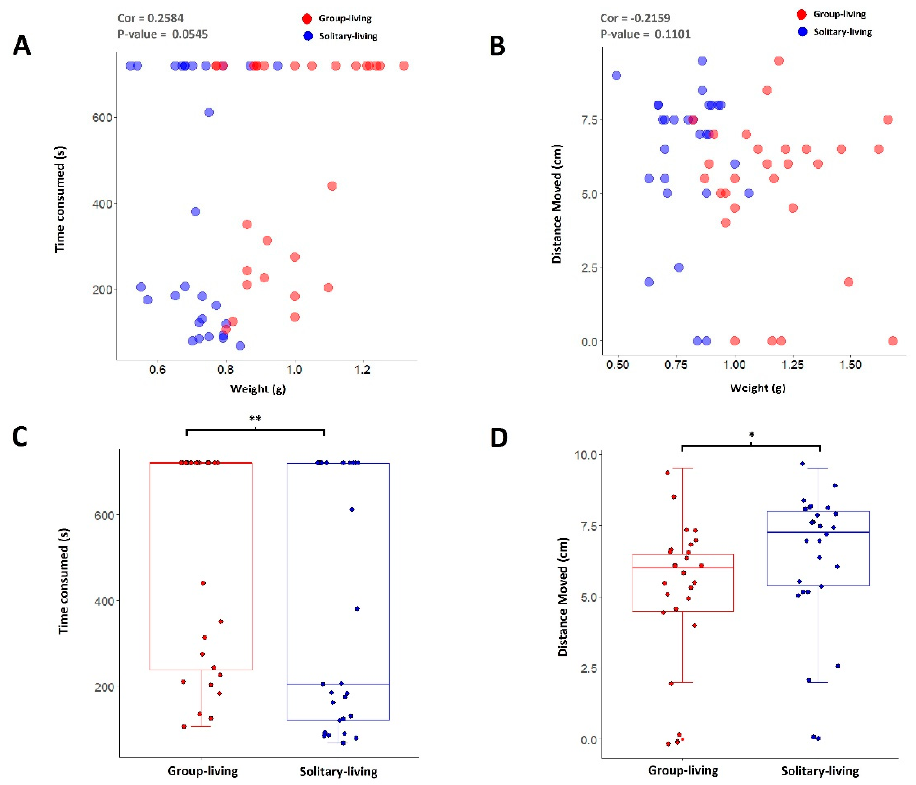
Figure 4. Correlation analysis between the weight of solitary/group-living silkworms and their performance in food luring or heat stress experiments. ( A ) is a scatterplot showing the correlation of the time taken to move and the body weight of solitary (blue)/group-living silkworms (red). ( B ) is a scatterplot showing the distance moved to evade heat stress and the body weight of solitary (blue) and group-living silkworms (red). ( C ) is a comparison of the time taken to move (corresponding to ( A )) between solitary and group-living silkworms. ( D ) is a comparison of the distance moved (corresponding to ( B )) to evade heat stress between solitary and group-living silkworms. The results of correlation analyses are shown at the head of each scatterplot. In ( C , D ), ‘*’ denotes p -value < 0.05 and ‘**’ denotes p -value < 0.01. Statistics are performed by Wilcox test.